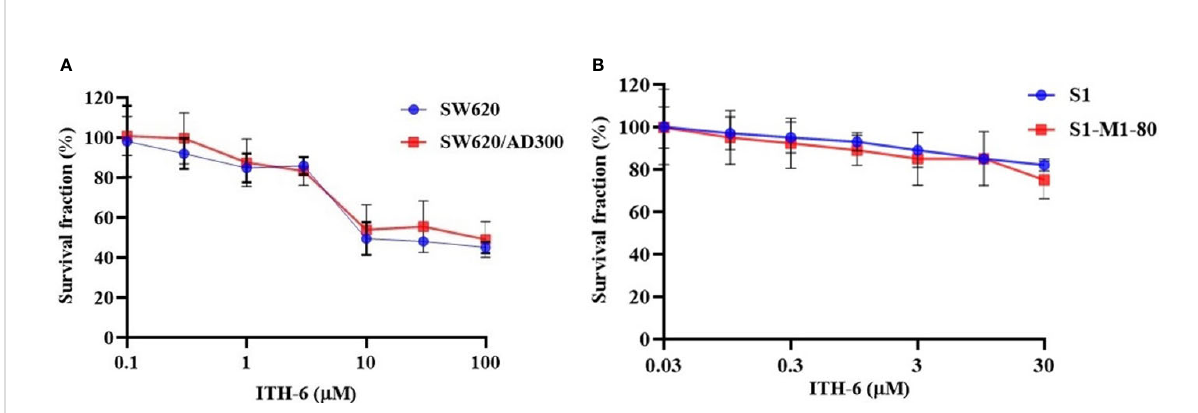
FIGURE 1 Cytotoxicity of ITH-6 on ABCB1- and ABCG2-overexpressing cell lines. Survival fraction (%) was measured after treatment with ITH-6 (µM) for 72 hours on (A) SW620, SW620/AD300 and (B) S1, S1-M1-80 cell lines. Points with error bars represent the mean ± SD for independent determinations in triplicate. The fi gures are representative of three independent